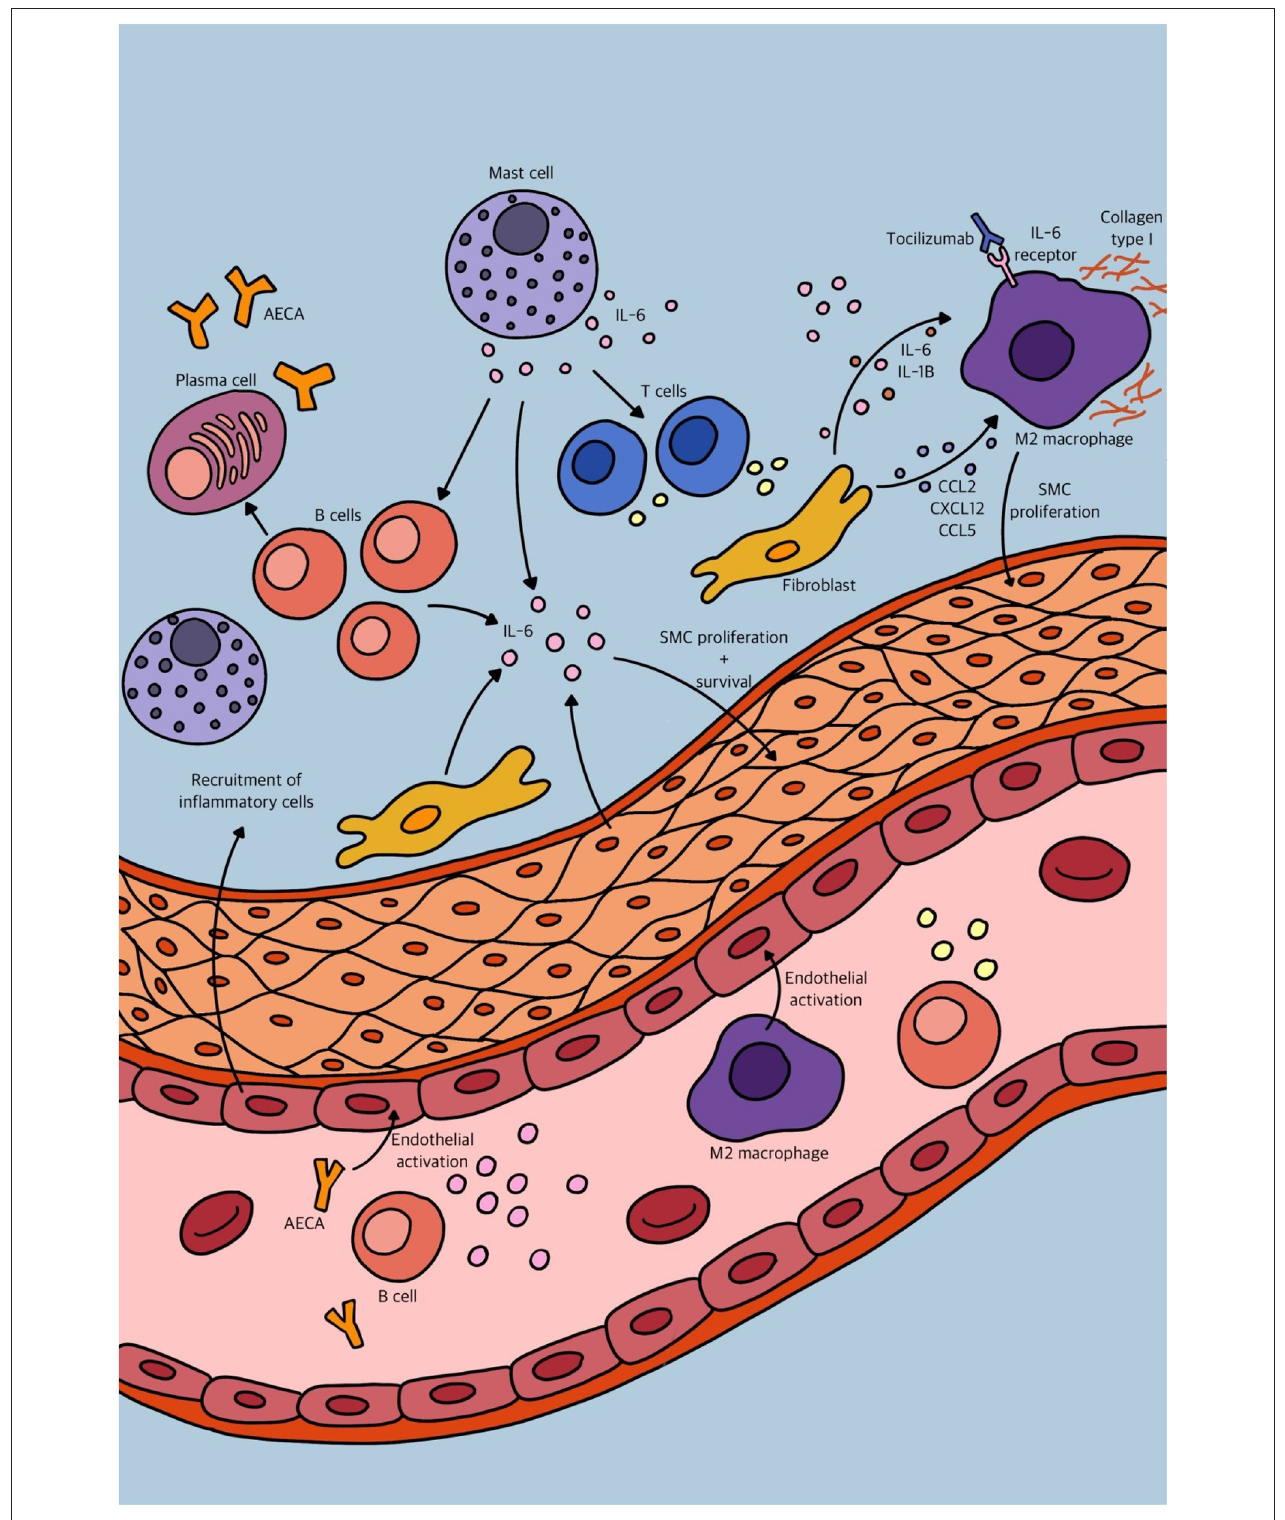
FIGURE 3 | Schematic overview of some of the different immunological mechanisms involved in vascular remodeling in pulmonary arterial hypertension (PAH).